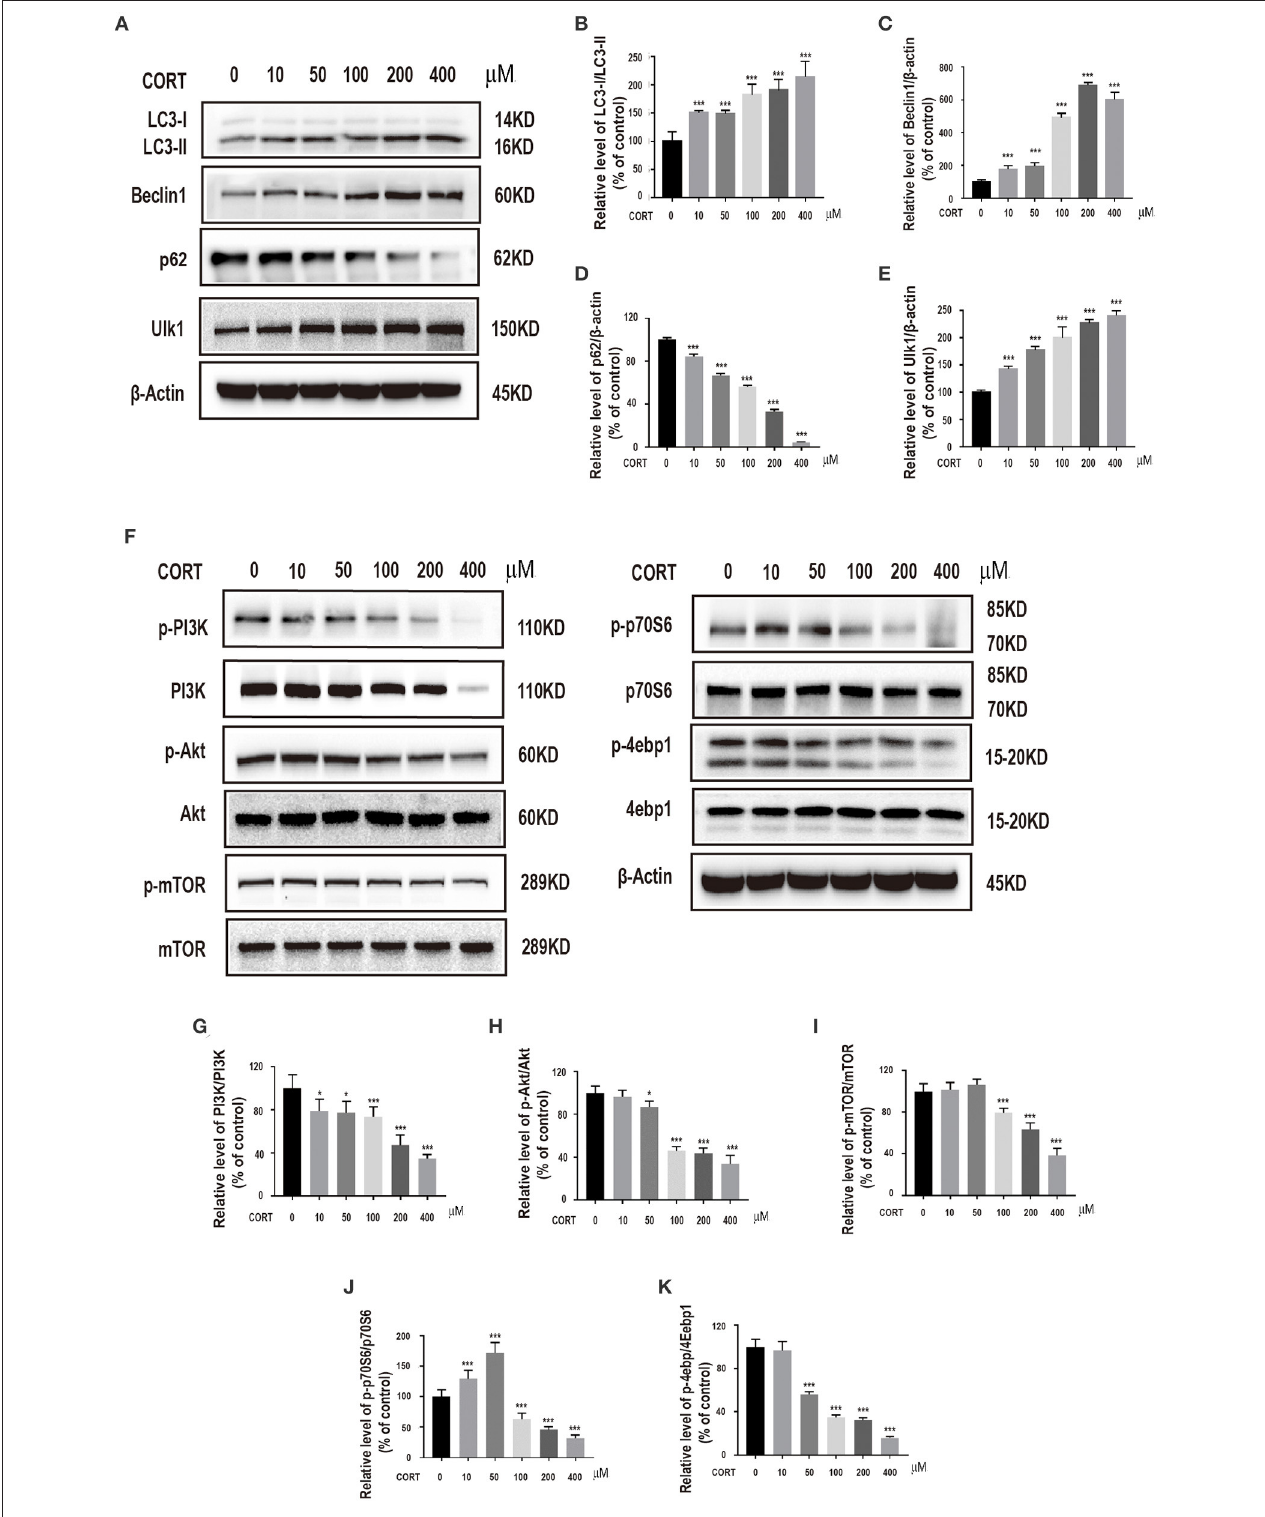
FIGURE 2 | Incubation of cells with different concentrations of corticosterone (10, 50, 100, 200, 400 µ M) for 24h. (A–E) Western blot and quantitative analyses of LC3-II/LC3-I protein ratio, and Beclin1, p62 and ULK1 protein expression levels. (F–K) Western blot and quantitative analyses of PI3K, p-PI3K, Akt, p-Akt, mTOR, p-mTOR, p70S6, p-p70S6, 4ebp1 and p-4ebp1 protein expression. Each column represents mean ± SD ( n = 3). * P < 0.05, *** P < 0.01 vs. control group.